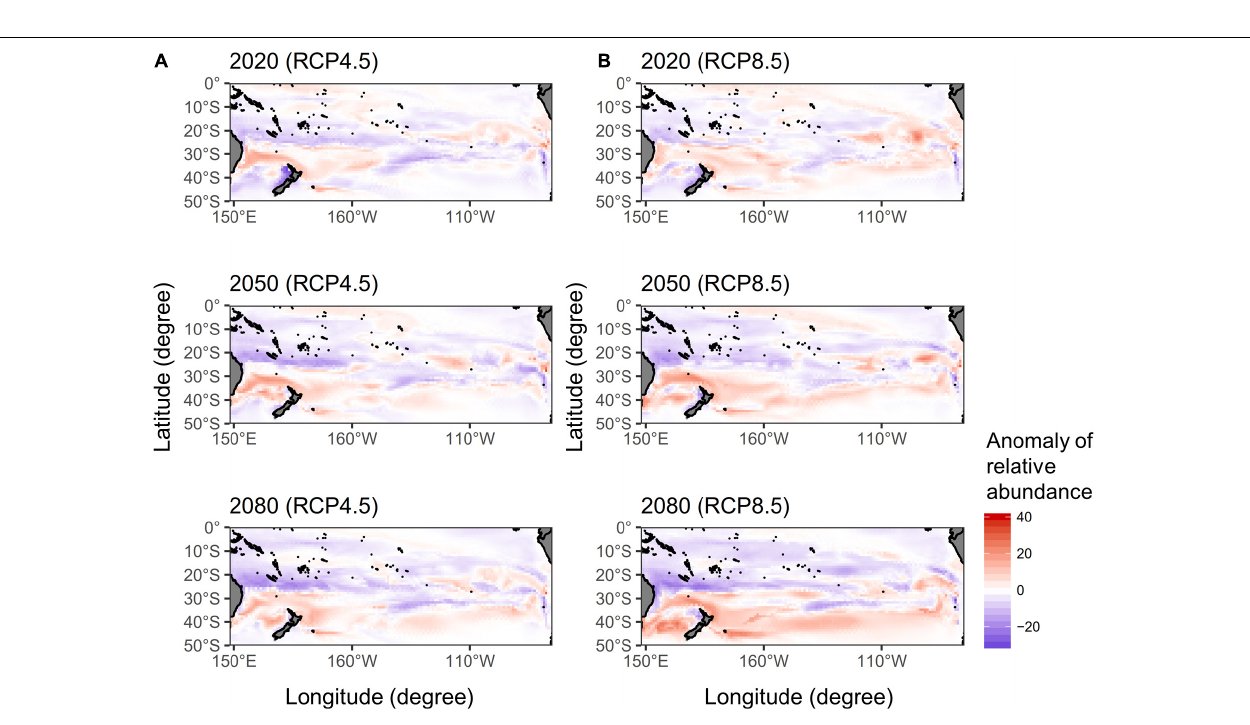
Frontiers in Marine Science |